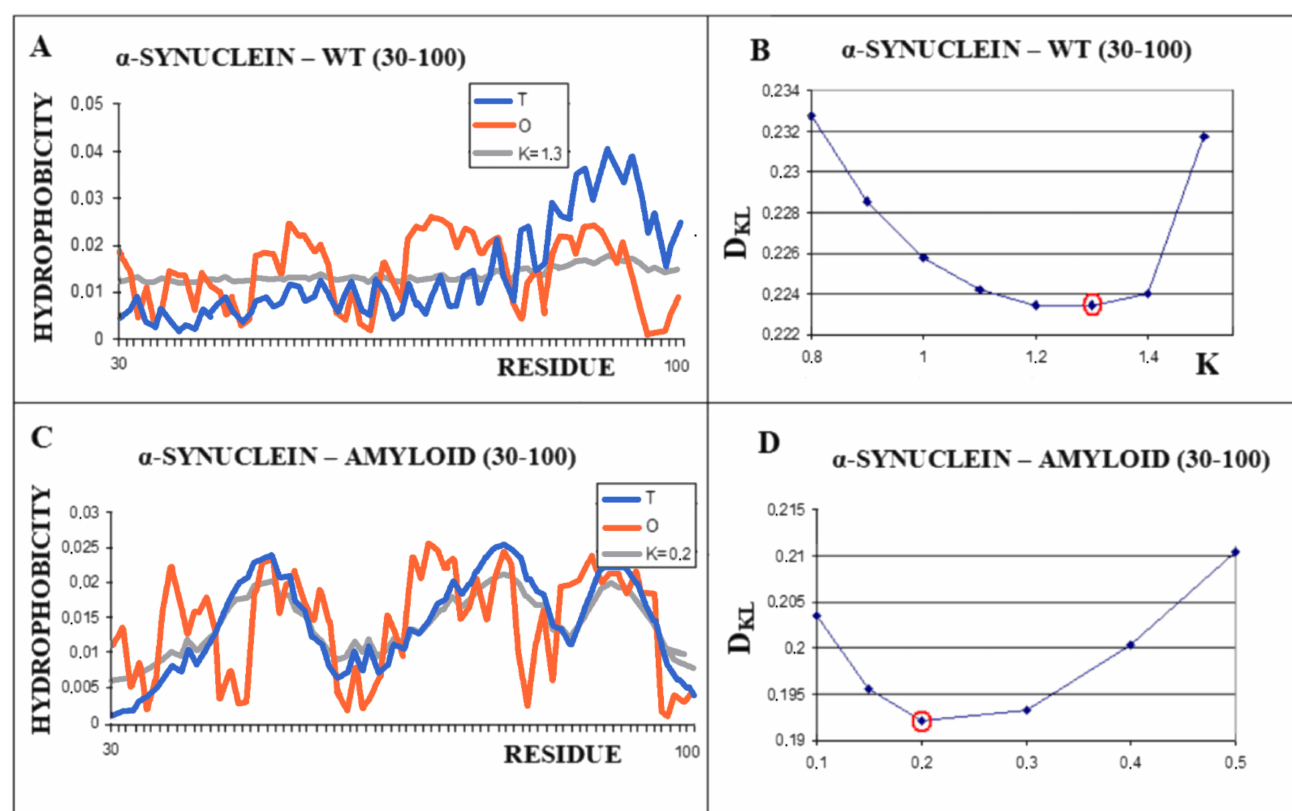
Figure 7. Characteristics of α -synuclein ( A )—Distributions of T-navy blue, O-red, and M-gray for the structure of the 30–100 α -synuclein as is appears in WT form. ( B )—Change in the D KL value for the O–M relation with different values of the K parameter. The smallest value K = 1.3 was indicated as representing the shortest distance between the O and M distribution. ( C )—Profiles of T-navy blue, O-red, and M-gray for the structure of the fragment 30–100 of a single chain of α -synuclein in the form present in amyloid. The M distribution is obtained for the parameter K = 0.2. ( D )—Change in the D KL value for the O–M relation with different values of the K parameter. The smallest value was indicated as representing the shortest distance between the O and M distribution.